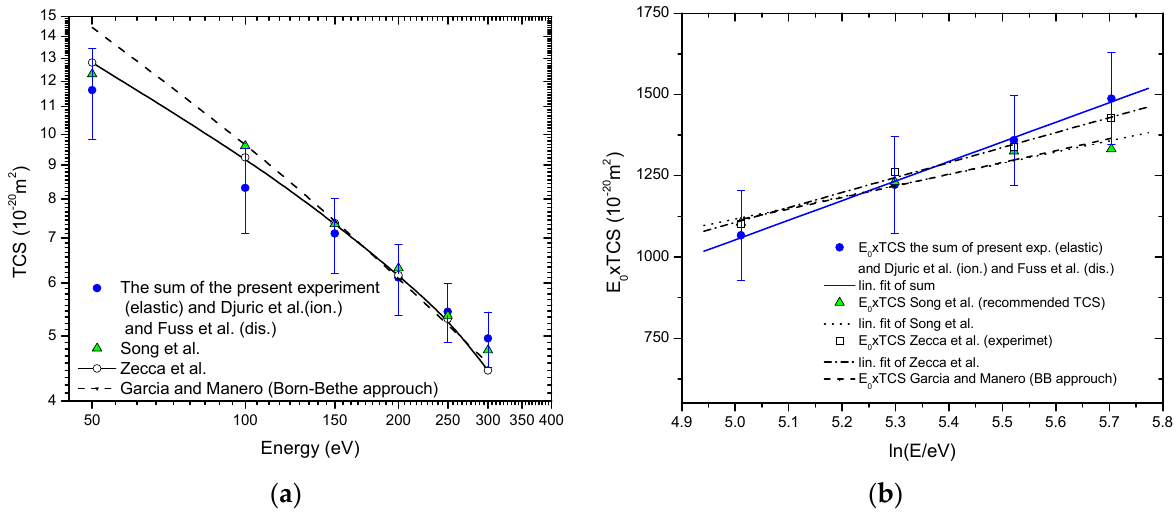
Figure 3. Total cross-sections for electron-methane collision in energy range from 45 eV to 300 eV. , present; , Song et al. (recommended values) [17]; , Zecca et al. (experiment) [51]; - - - , García and Manero (Born-Bethe approach) [52]: ( a ) Absolute values; ( b ) The Fano-Bethe plot: , linear fit of present; • • •, linear fit of Song et al. [17]; ̶ ∙ ̶ ∙ linear fit of Zecca et al.[51].